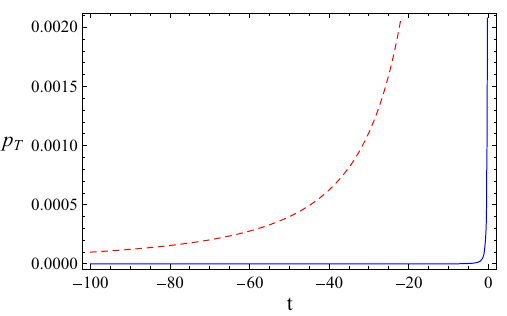
Fig. 3 Tangential pressure as a function of time at the center (dashed line) and surface (solid line) of the star